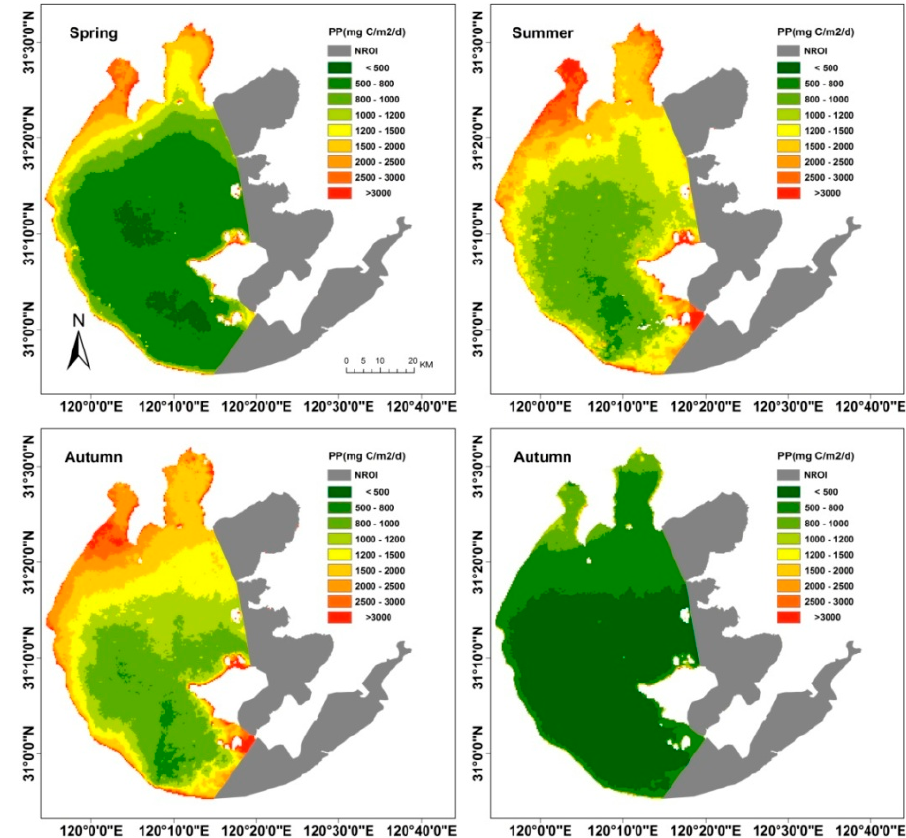
Figure 4. Maps of the MODIS-derived mean daily phytoplankton primary production for the four seasons in Lake Taihu generated using the VGPM.